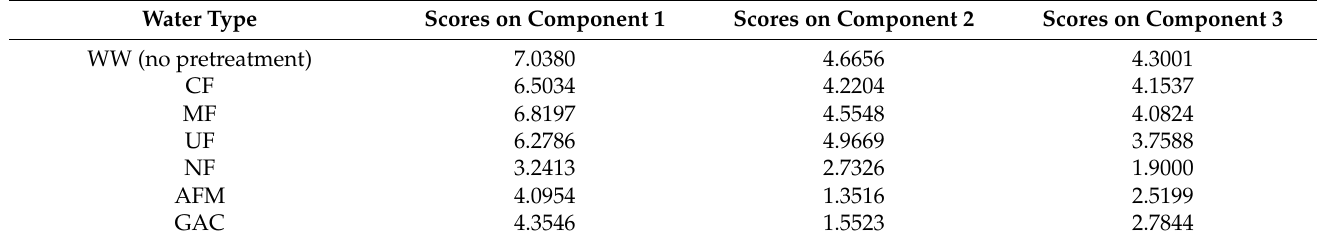
Table 10. Scores on three components in PARAFAC model for raw feed water (WW) and pretreated water. Water Type Scores on Component